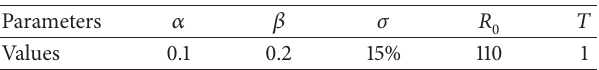
Table 8: Parameters involved in CIR interest